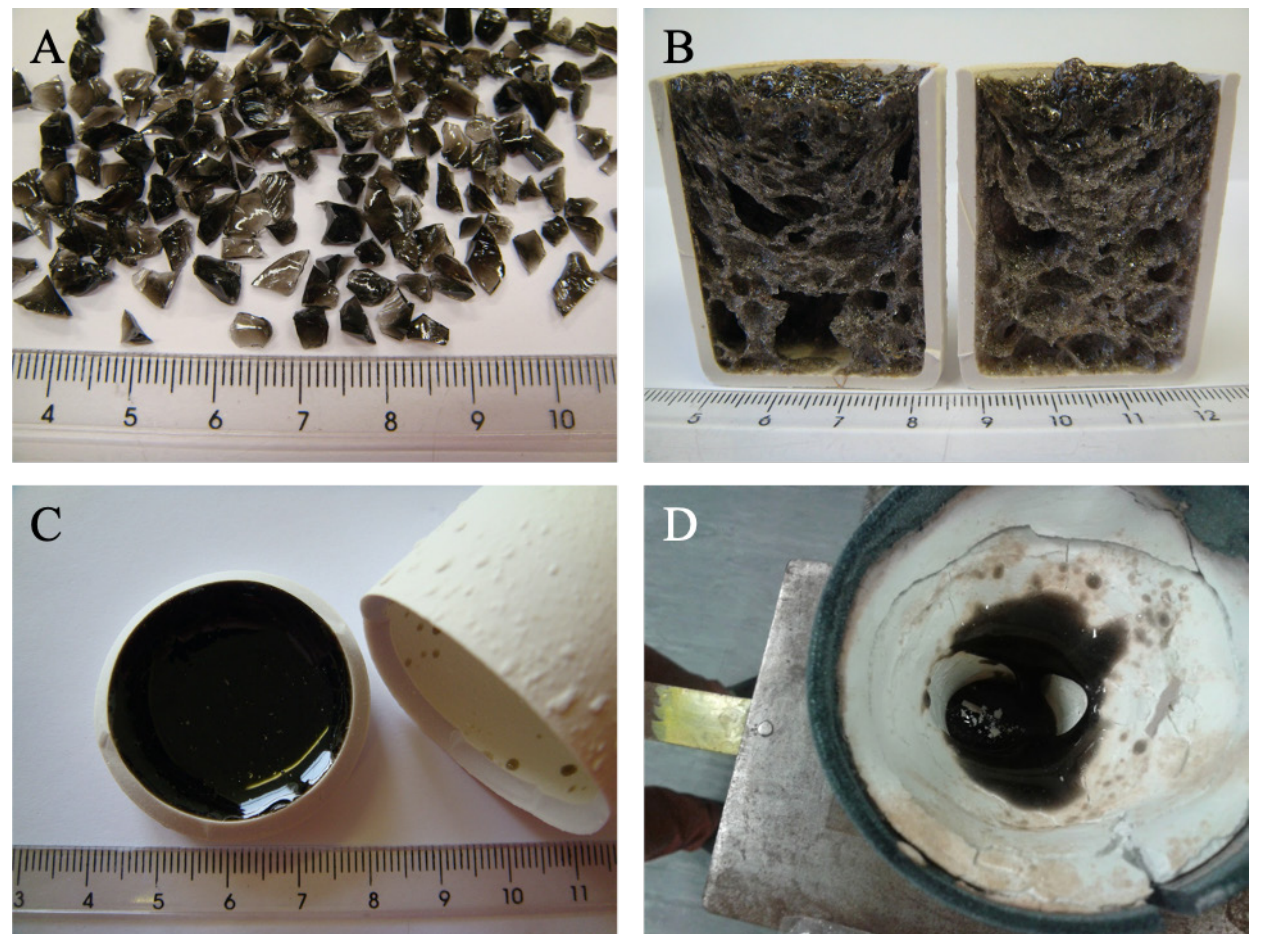
Figure 5: Photographic notes from the experimentation and making process during the production of ‘PEDM’ (Figure 1C). [A] The starting obsidian (from the Roche Rosse lavas, Lipari, Italy) crushed to 2–3 mm chips. [B] The obsidian chips after a processing step involving heating in alumina crucibles to 1200 °C for 24 hours. [C] The result of the second heating step in which the product shown in [B] is crushed to a fine powder and then reheated in a crucible, producing a densely welded obsidian glaze. [D] The top-view of the mold after